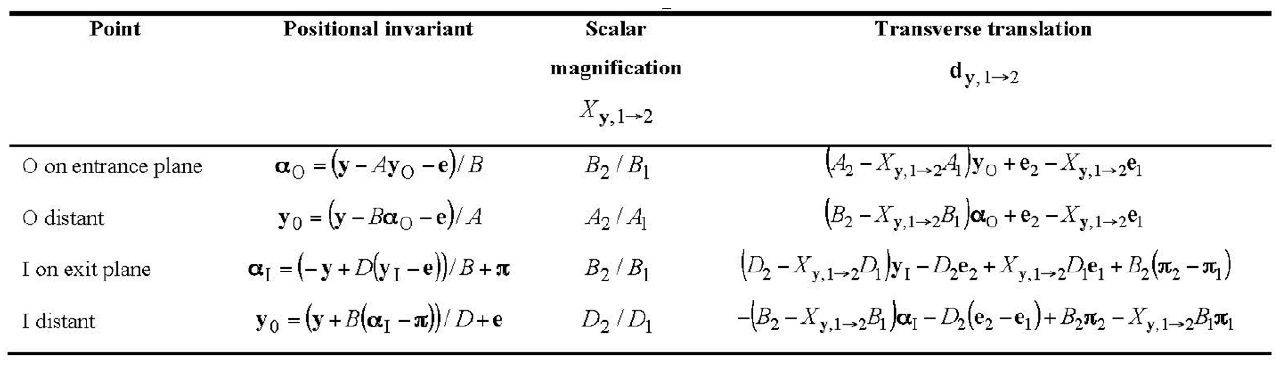
Table 2 Inclinational invariant along a ray through an object (O) or image (I) point and scalar magnification X